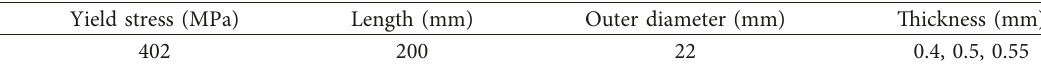
Figure 4: Experimental setup of the quasistatic tests. (a) Tube-crushing dissipator. (b) Symmetric tube-crushing dissipator. Table 1: Parameters of the 304 stainless steel tubes.